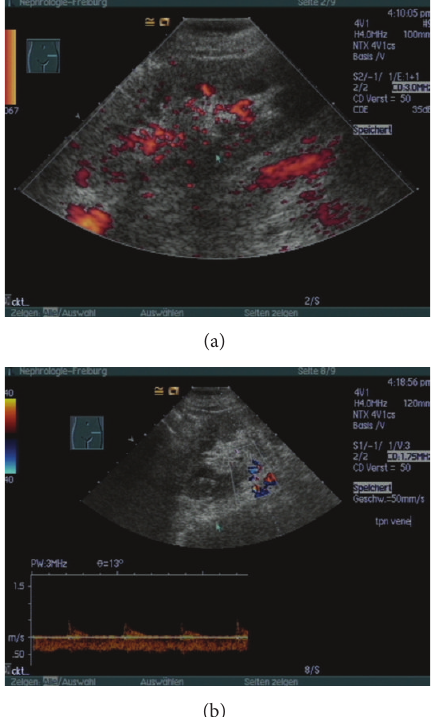
Figure 2: Duplex ultrasonography of the transplanted kidney 3hs after transplantation; free perfusion of vein and artery, peripheral perfusion deficit, high resistance indices, and prominent pyramids are characteristic for acute renal failure.